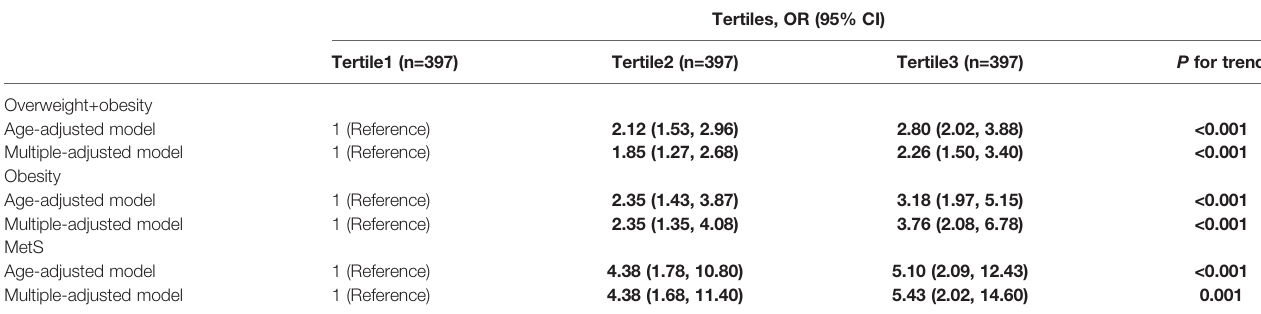
TABLE 3 | Multivariable adjusted odds ratios and 95% con fi dence interval (CI) for overweight, obesity, and metabolic syndrome (MetS) across C1q tertiles. Tertiles, OR (95% CI) Tertile1 (n=397) Tertile2 (n=397) Tertile3 (n=397)